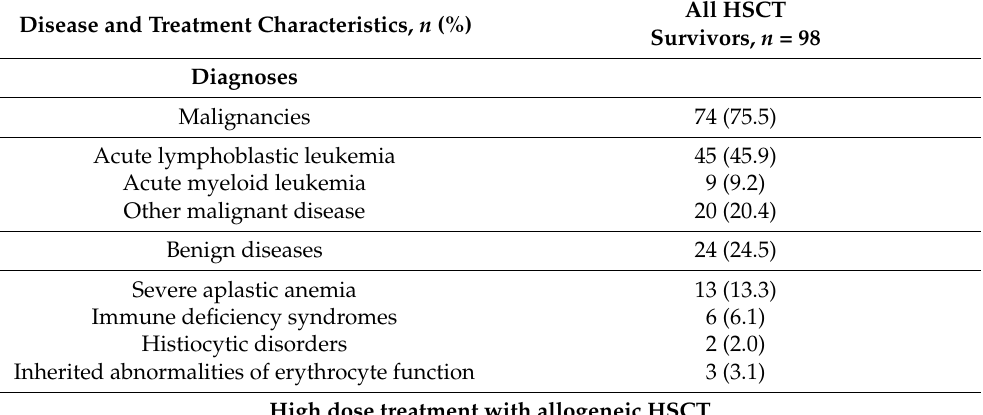
Table 2. Disease and treatment characteristics of all study